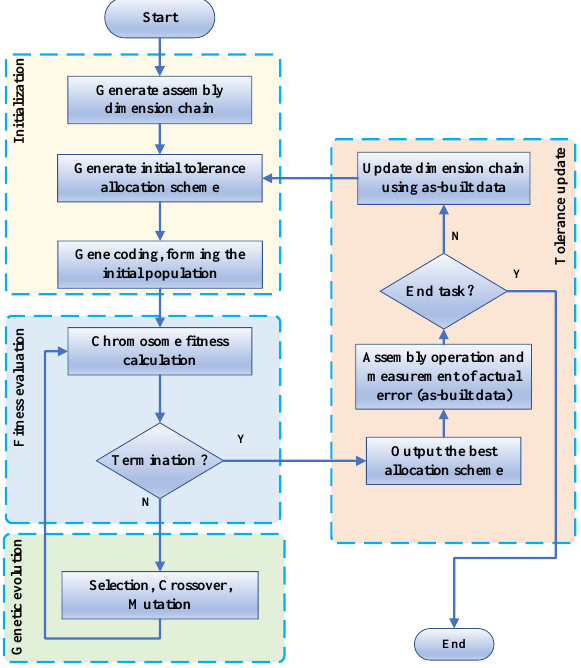
Figure 12. Dynamic tolerance optimization flow using GA and as-built data.